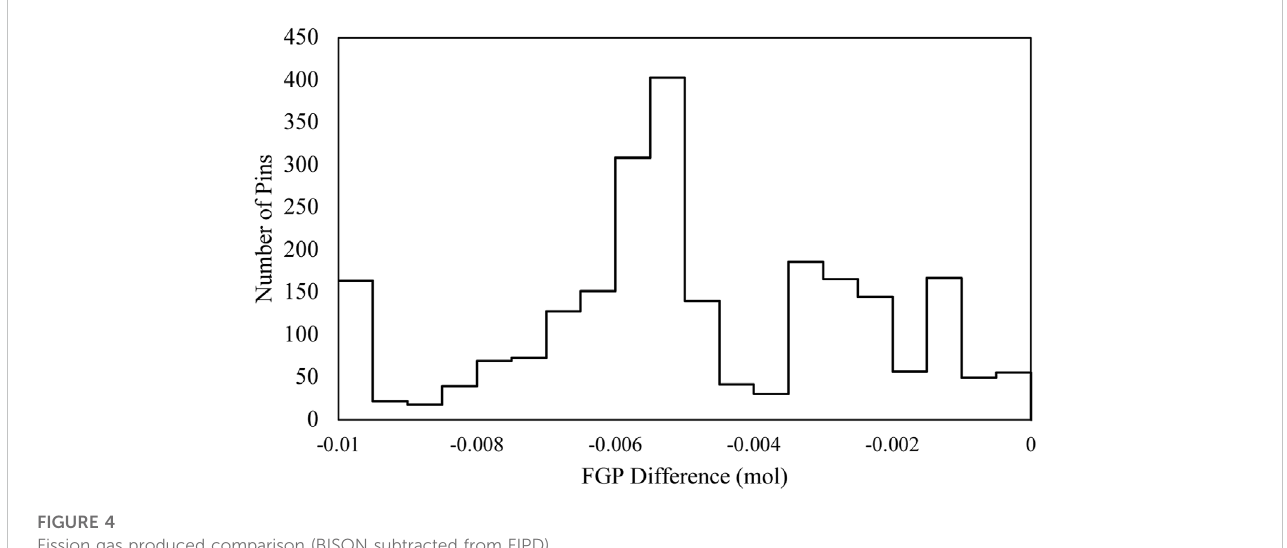
Fission gas collected comparison (BISON subtracted from